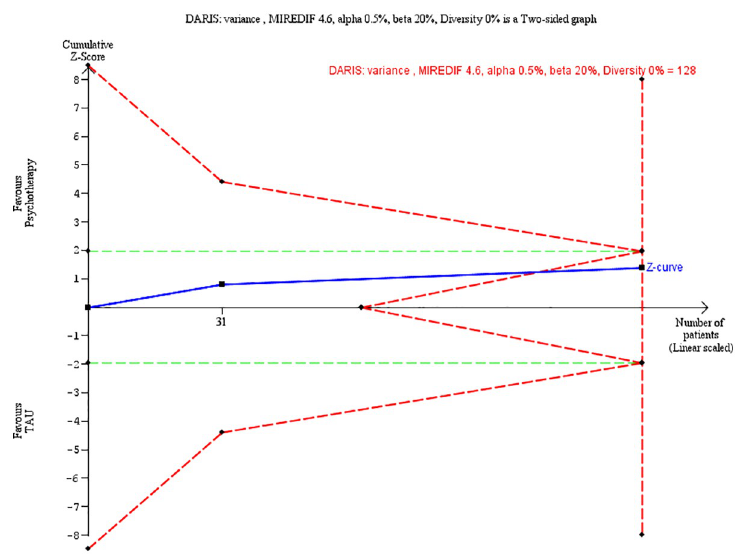
Fig 4. Trial Sequential Analysis for ERT.